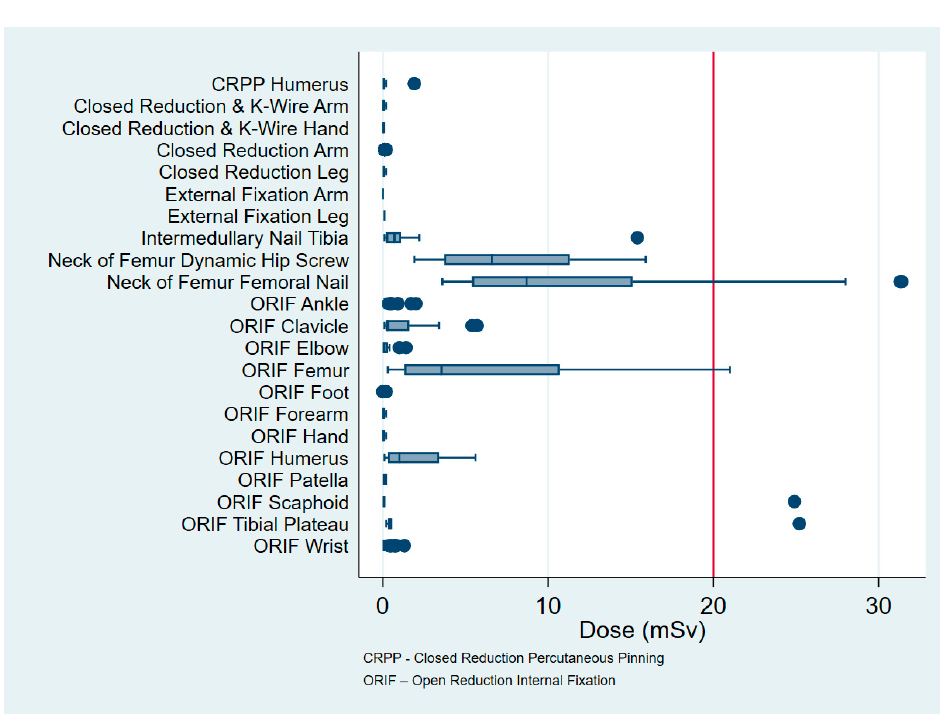
Figure 3. Radiation exposure by procedure.